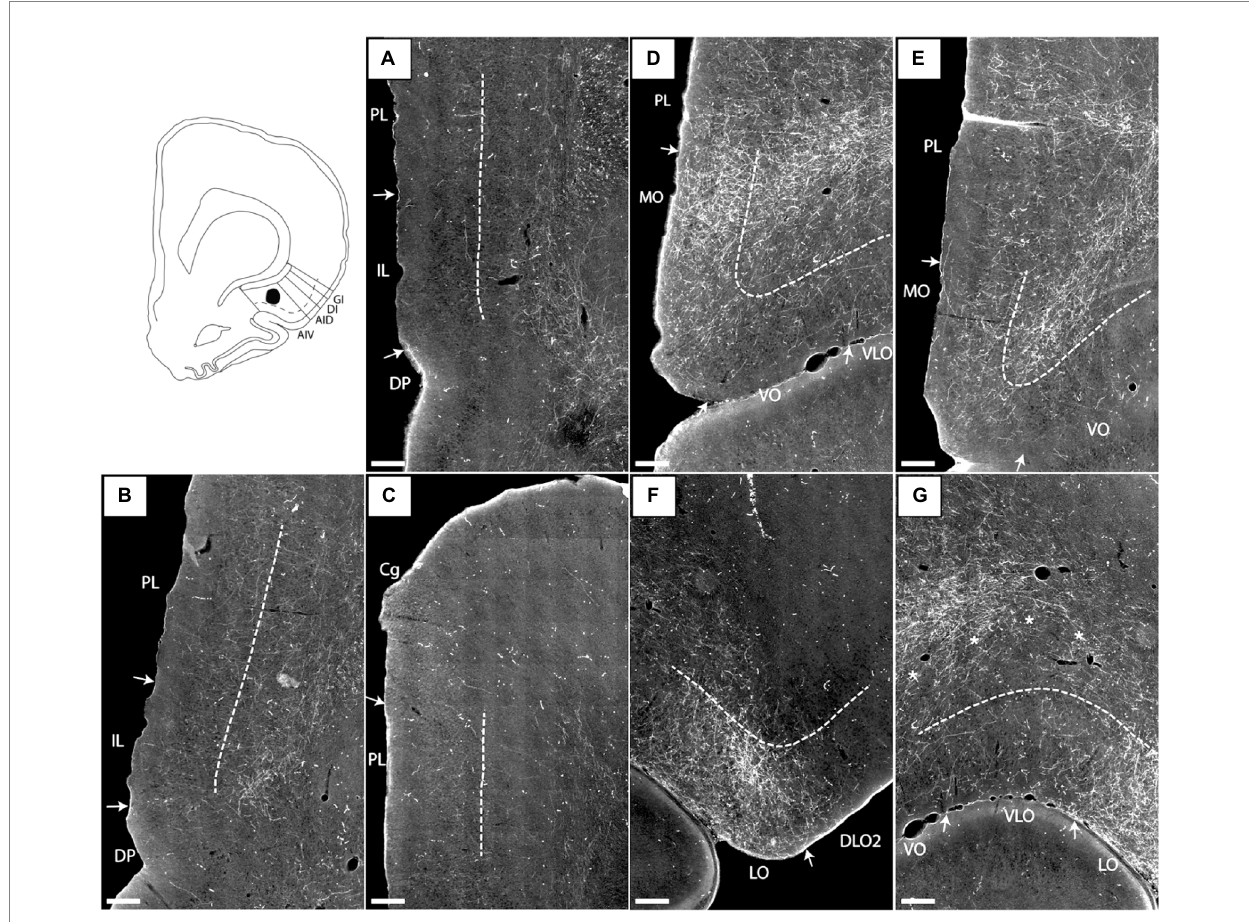
FIGURE 2 Images visualizing the fiber labeling resulting from a BDA injection covering the deep layers of the ventral agranular insular field (AIV) in the anterior insular cortex (case 15876B). A schematic depicting the injection is shown in the upper left corner. (A–C) Moderately dense labeling is seen in infralimbic cortex (IL), extending into the dorsal peduncular cortex (DP). More moderate diffuse labeling is seen in prelimbic cortex (PL) with a weak-to- moderate labeling in the anterior cingulate cortex (Cg). (D,E) At rostral portions more dense and focused fiber labeling is present in the ventral portion of the prelimbic cortex extending into an even denser labeled fiber plexus in the medial orbital field (MO). (F,G) Additional dense labeling is present in the lateral orbital field with only weak fiber labeling in other orbital fields. Dashed lines indicate the border between layers 3 and 5. The asterisks in G indicate the deep border of VLO and VO. VLO, ventrolateral orbital field; VO, ventral orbital field. Scale bars equal 250 μ